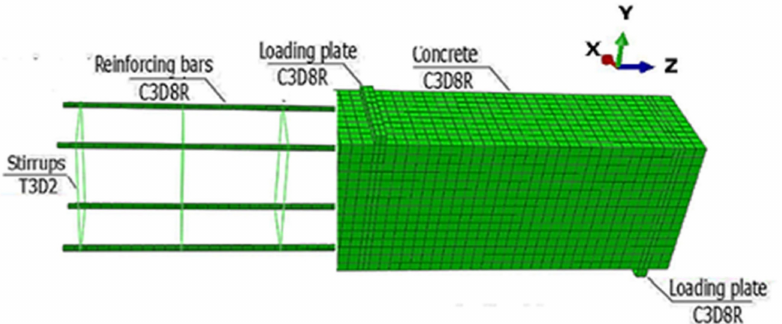
Figure 3. Beam modelling, mesh, and boundary conditions.